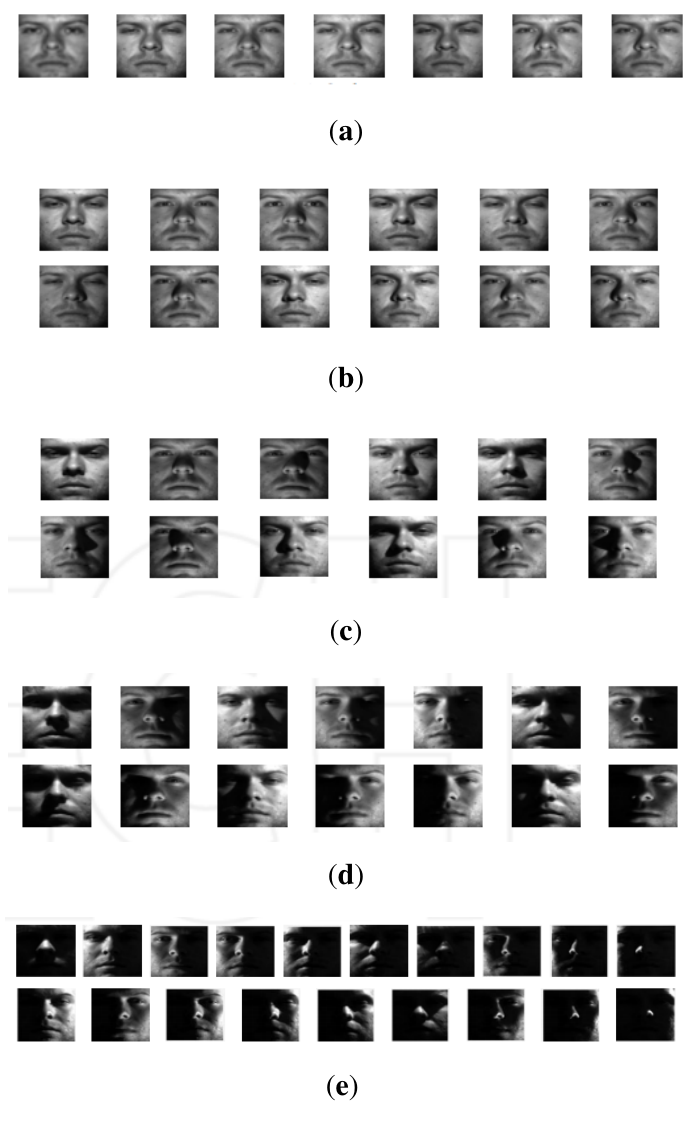
Figure 3. All images from a single subject enrolled in the Extended Yale B database. Images ( a ) to ( e ) correspond to Subsets 1 to 5 ,